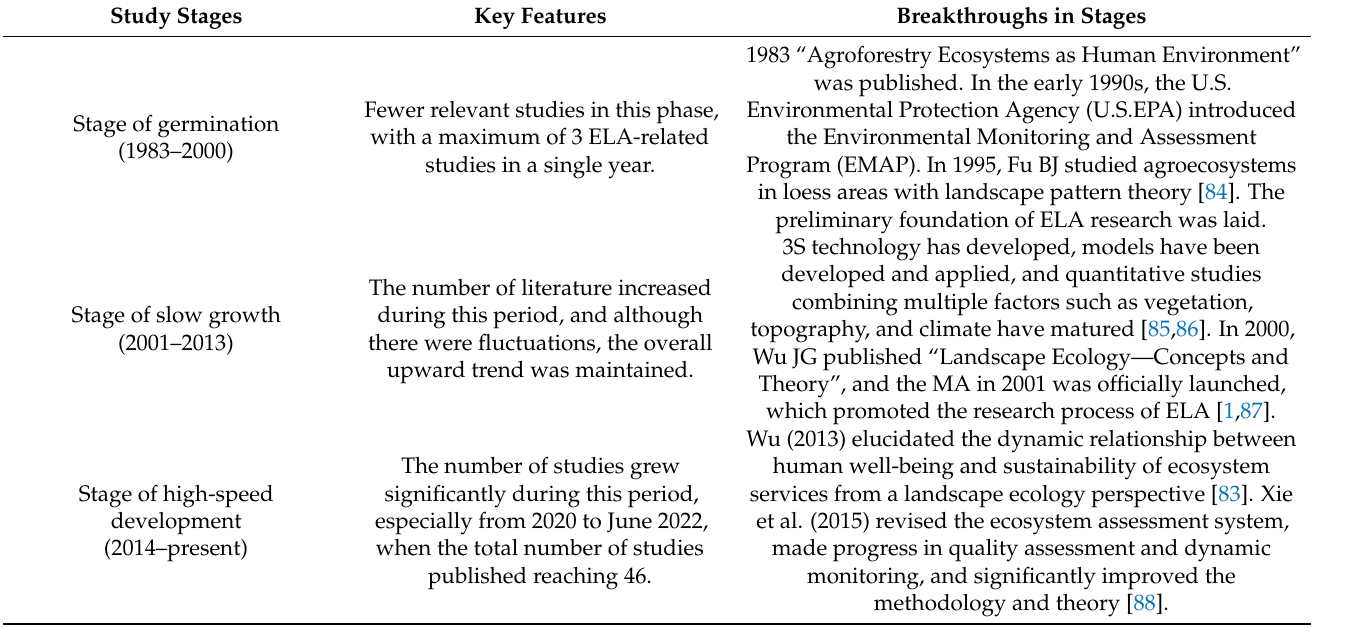
Table 3. Division of research